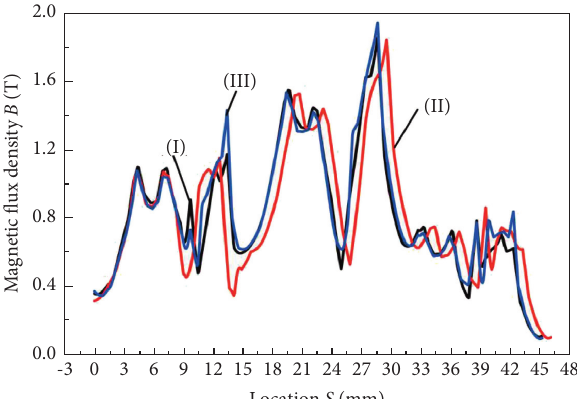
Figure 5: Magnetic field distribution in magnetic fluid sealing clearance with different axial teeth numbers (I), 1; (II), 2; and (III), 3.